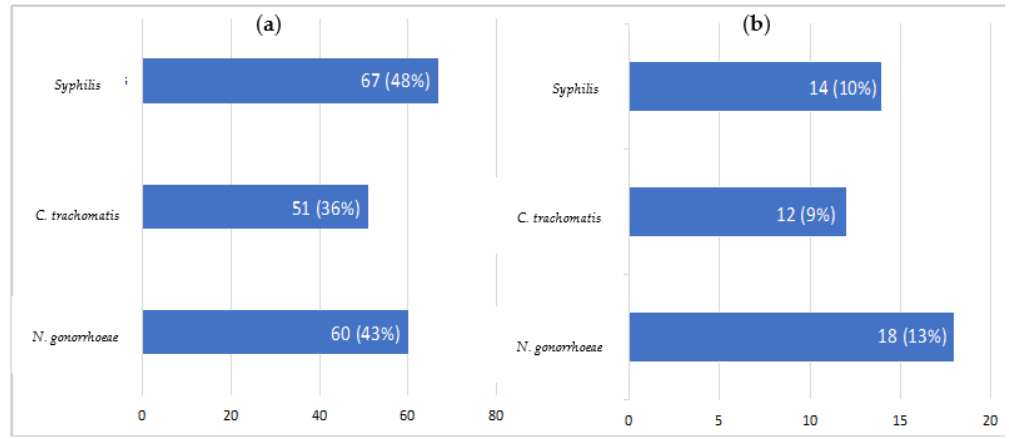
Figure 1. Previous ( a ) and concomitant ( b ) STIs.